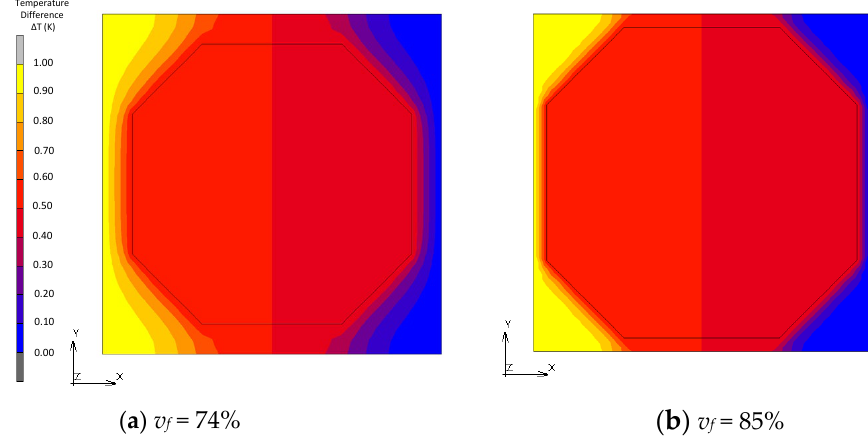
Figure 12. Temperature distribution of BCC models.